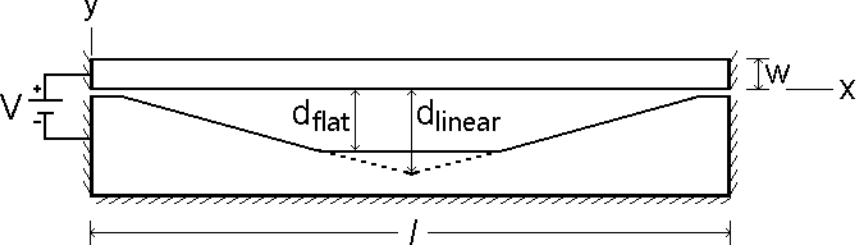
Figure 8. Linearly varying beam profile with flattened bottom.